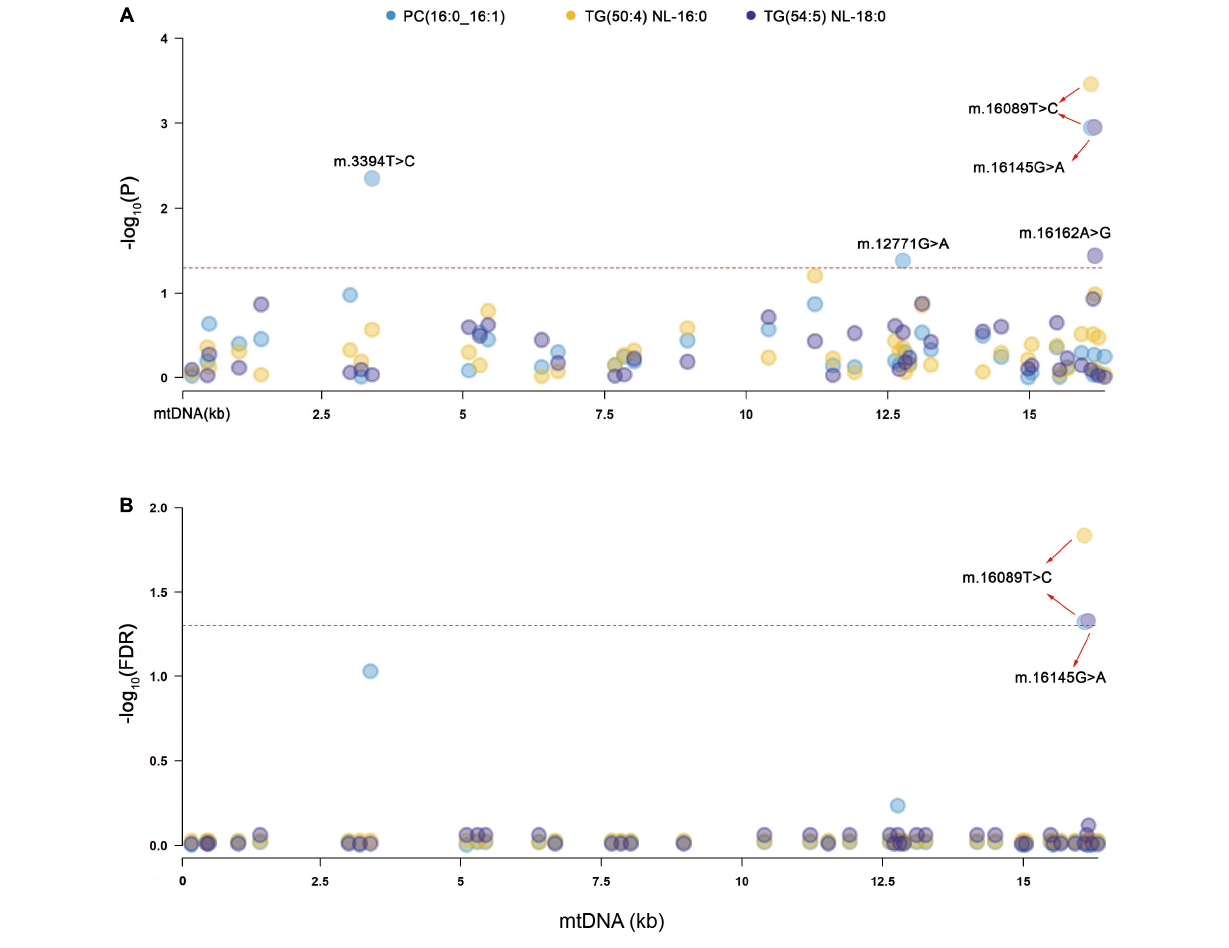
FIGURE 1 | Manhattan plots for the significant associations of mitochondrial genetic variants with lipid species. PC, phosphatidylcholines, TG, triacylglycerol. (A) The red dashed line indicates the threshold of nominal significance on lipid species ( P < 0.05). (B) The red dashed line indicates the threshold of statistical significance on lipid species after corrected (FDR <